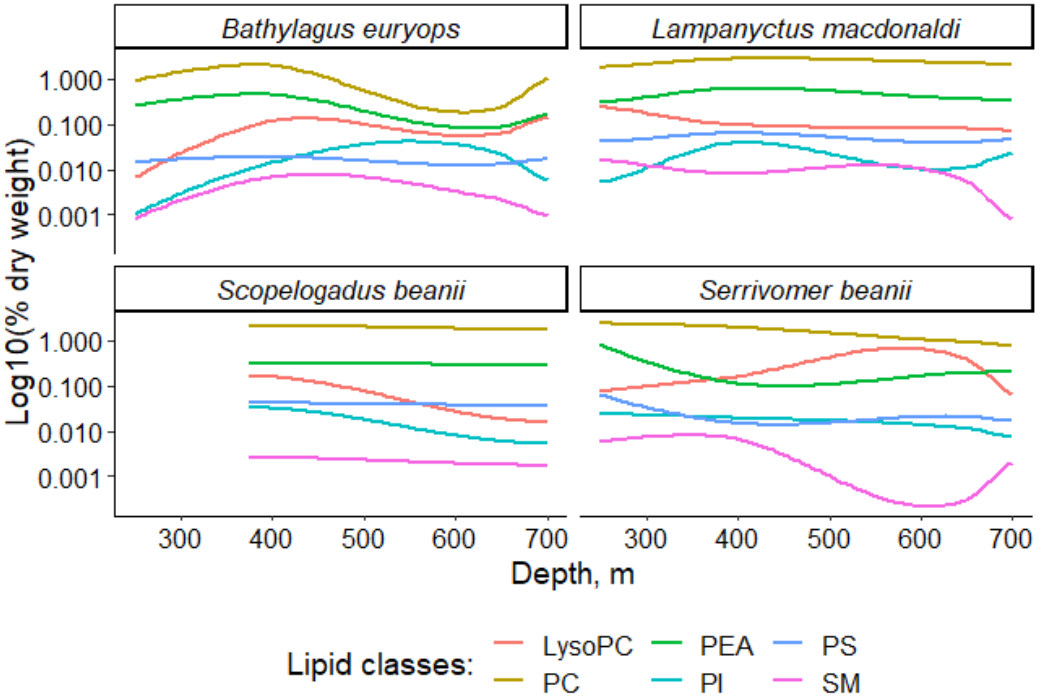
Figure 6. Patterns of change in individual phospholipid classes in muscles of mesopelagic fish species ( Bathylagus euryops , Lampanyctus macdonaldi , Scopelogadus beanii , Serrivomer beanii ) living at different depths in the Irminger Sea (North Atlantic). Note: abbreviations used as in Figure 5. Table 2. The content of certain phospholipid fractions (% dry weight) in muscle tissue of mesopelagic fishes from Irminger Sea and Tropic